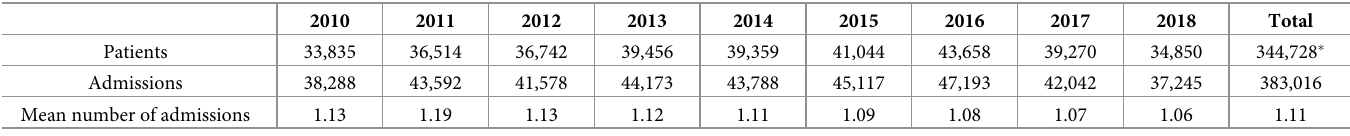
Table 1. Number of admissions related to falls, between 2010 and 2018, in the Portuguese population.